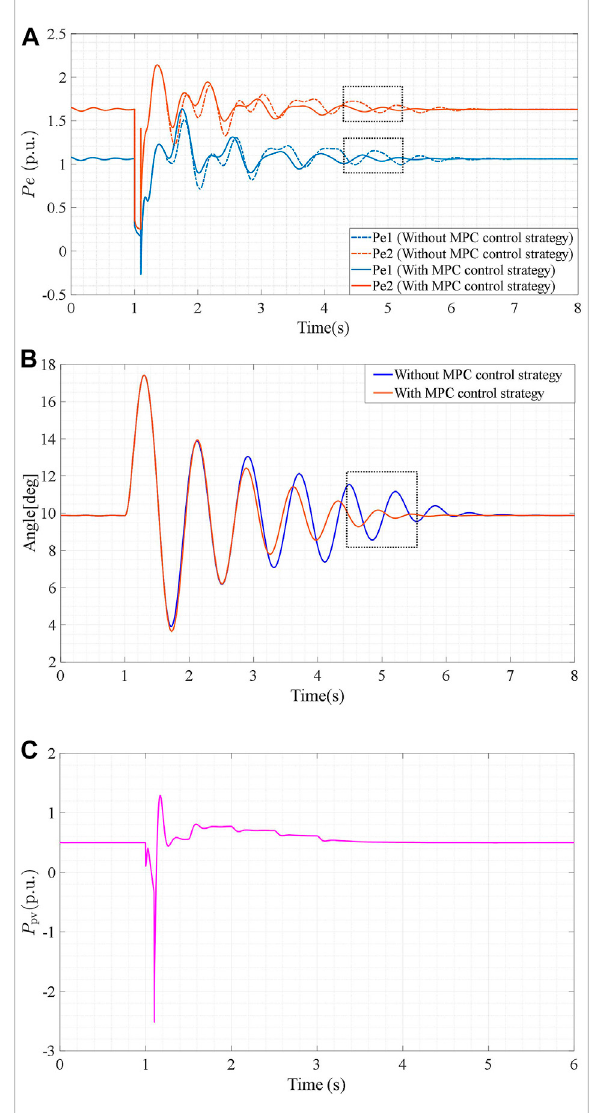
FIGURE 8 (A) : Dynamic performances of the active electromagnetic output powers Pe 1 and Pe 2. (B) : Transient angles of generator 1 δ 1 in the power grid. (C) : Active power output of the PV